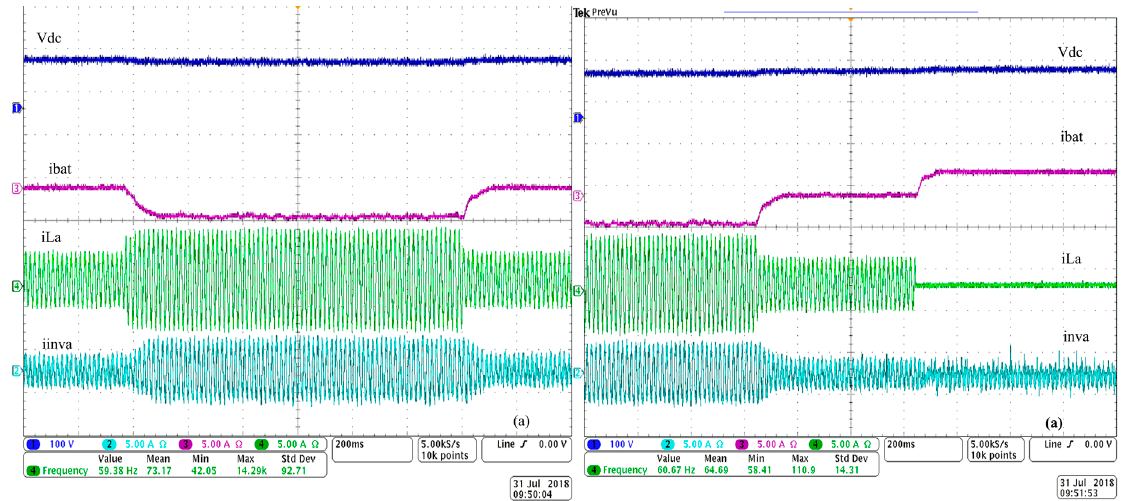
Figure 14. Dynamic performance under fixed solar irradiation and load change. ( a ) sudden increase and decrease of load; and ( b ) sudden decrease and disconnect of